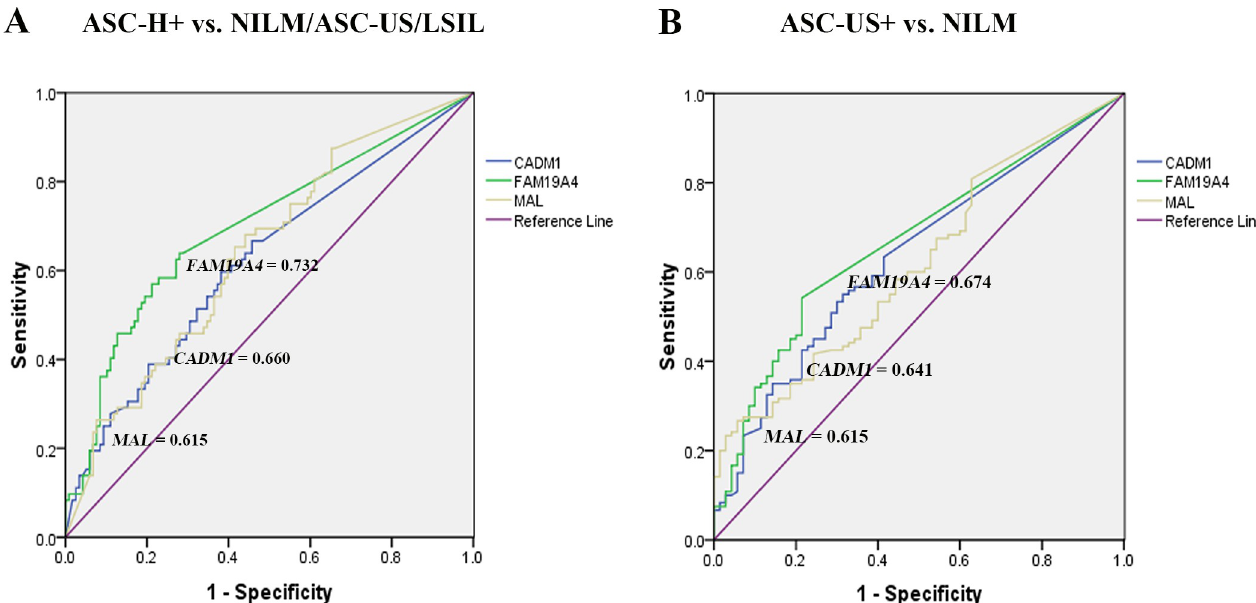
Fig 4. The ROC curve analysis of three methylation markers in differentiating cytologic ASC-H+ from NILM/ASC-US/LSIL (A) and cytologic ASC-US+ from NILM (B).